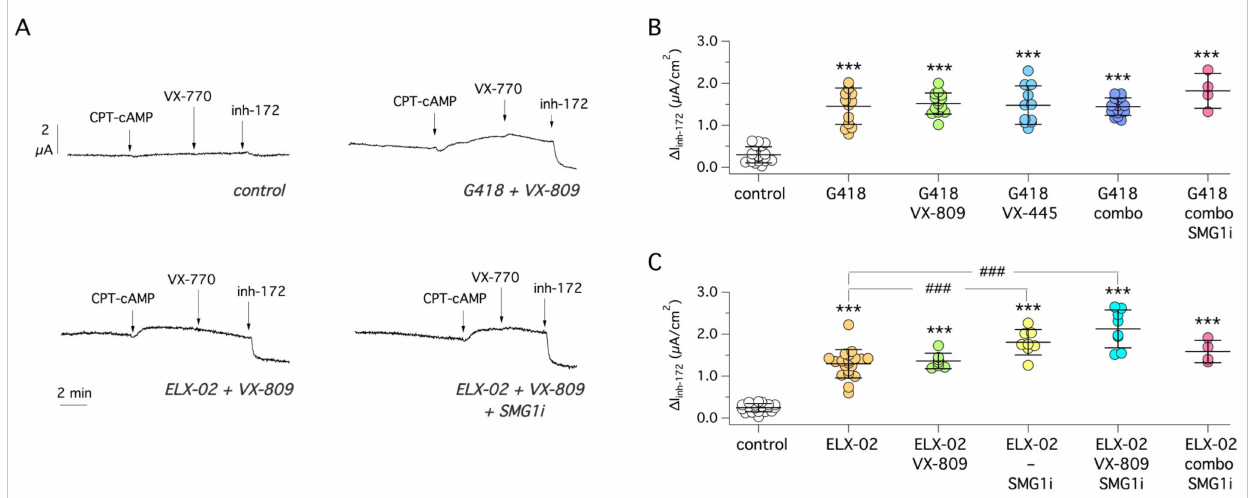
Figure 3. Pharmacological rescue of Y122X-CFTR mutant. ( A ) Representative short-circuit current traces from 16HBE14o- cells expressing Y122X-CFTR treated with the indicated compounds. ( B ) Scatter dot plot summarizing functional results obtained with combinations of G418, VX-809 (1 µ M), VX-445 (5 µ M), VX-809 plus VX-445 (combo), and SMG1i (1 µ M). ***, p < 0.001 vs. control. ( C ) Scatter dot plot summarizing functional results obtained with ELX-02 as readthrough agent, with/without correctors and/or SMG1i. ***, p < 0.001 vs. control; ###, p < 0.001 vs.